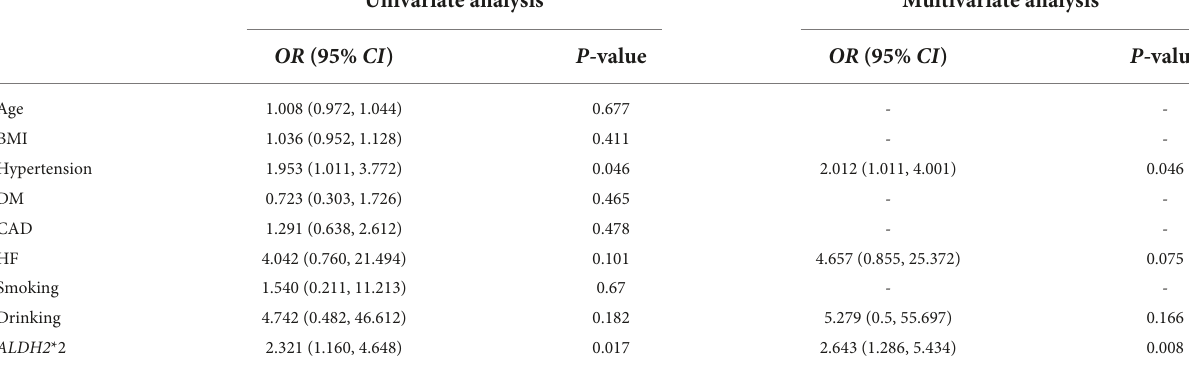
TABLE 6 Logistic regression analyses to explore the risk factors of persistent AF in female patients. Univariate